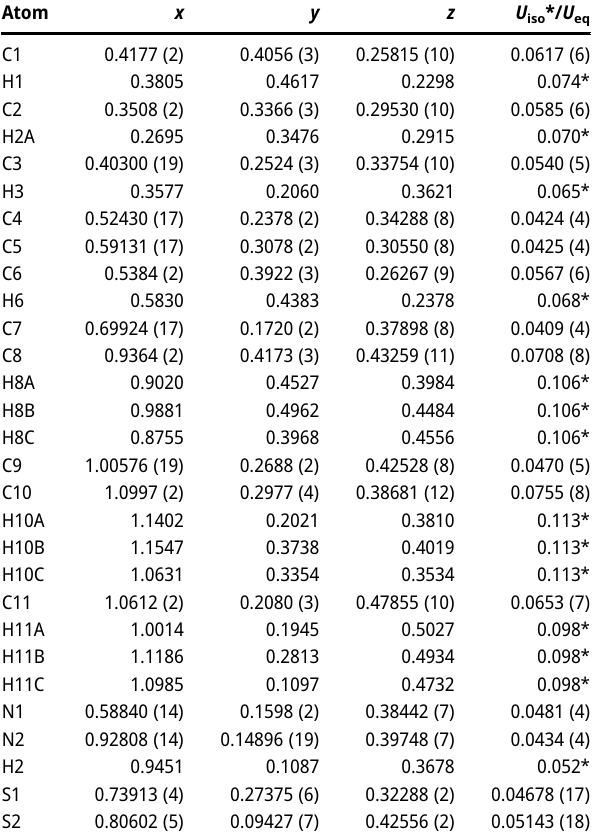
Table  : Fractional atomic coordinates and isotropic or equivalent isotropic displacement parameters (Å 